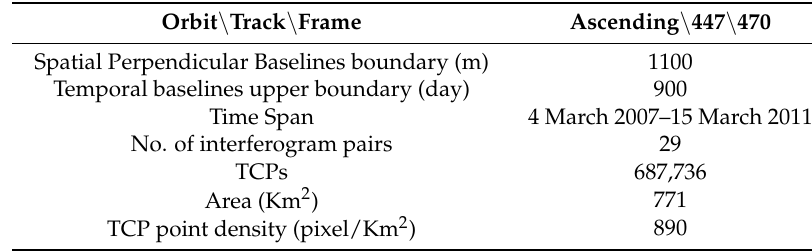
Table 2. Information about 15 ALOS/PALSAR images over